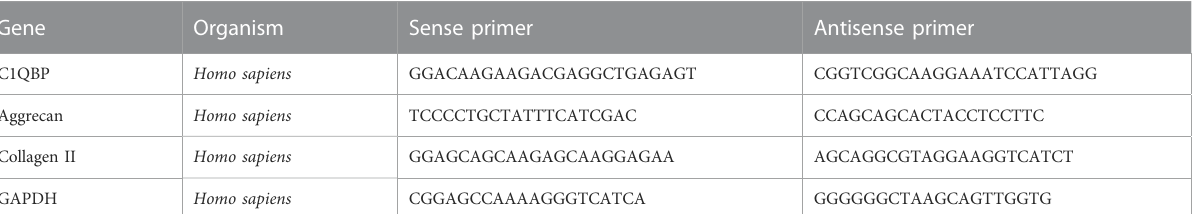
TABLE 2 Primer sequences used for RT-qPCR